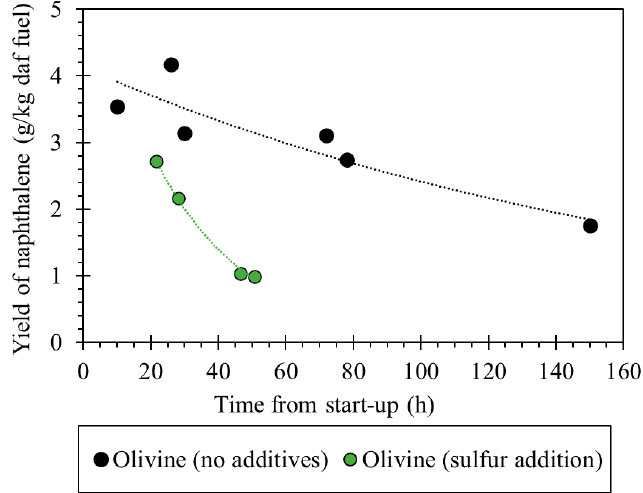
Figure 7. Comparison of activation levels of olivine (assessed as yields of naphthalene from the process) in the Chalmers DFB gasifier operating with the biomass with and without addition of sulfur to the bed.